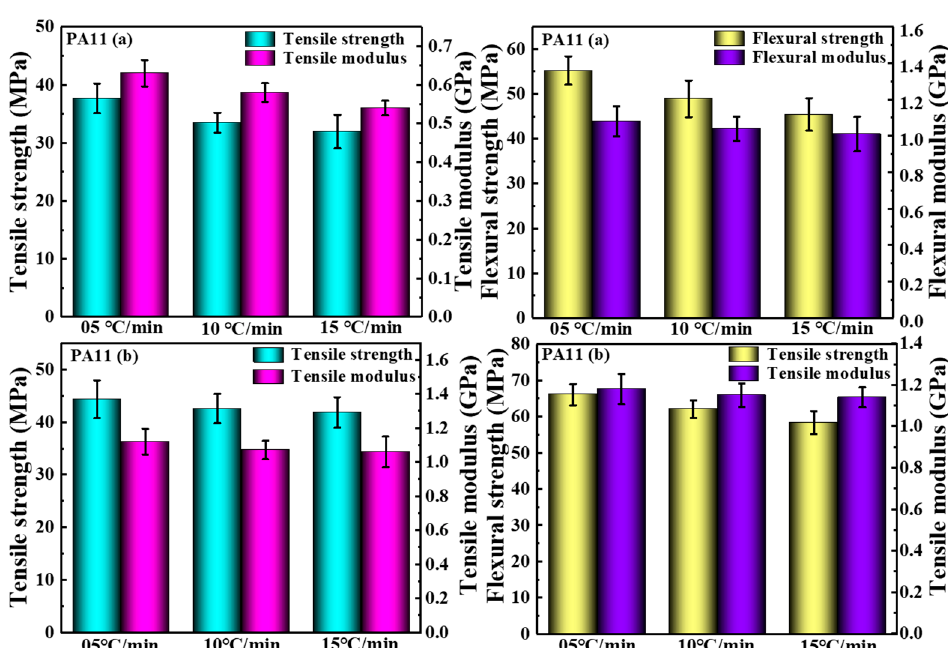
Figure 10. Stress–strain curves of the PA11 specimens.